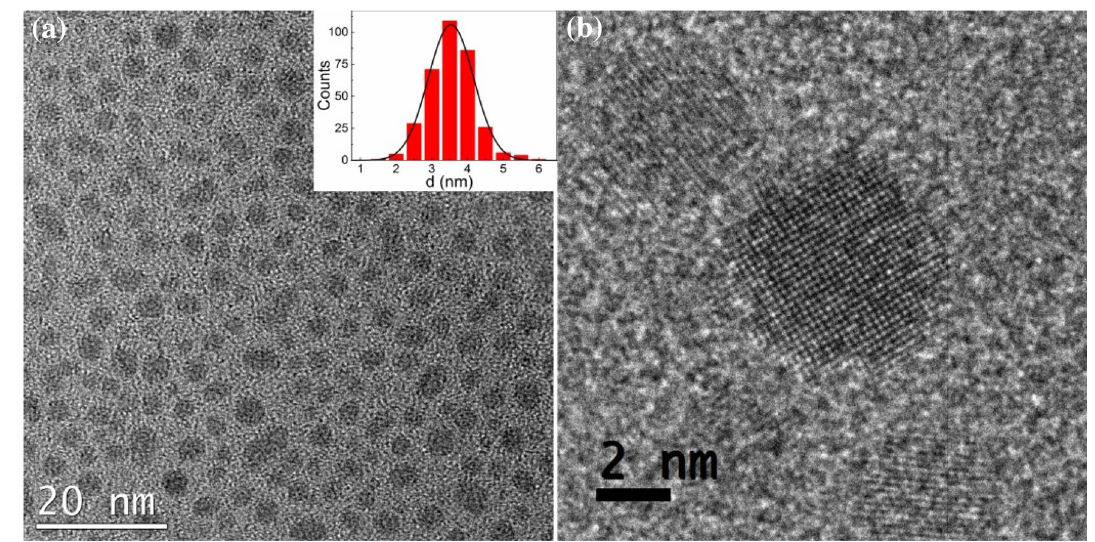
Fig. 6 a Low magnification image of Ni nanoparticles. Inset shows the size distribution of the particles, b HRTEM image of Ni nanoparticles